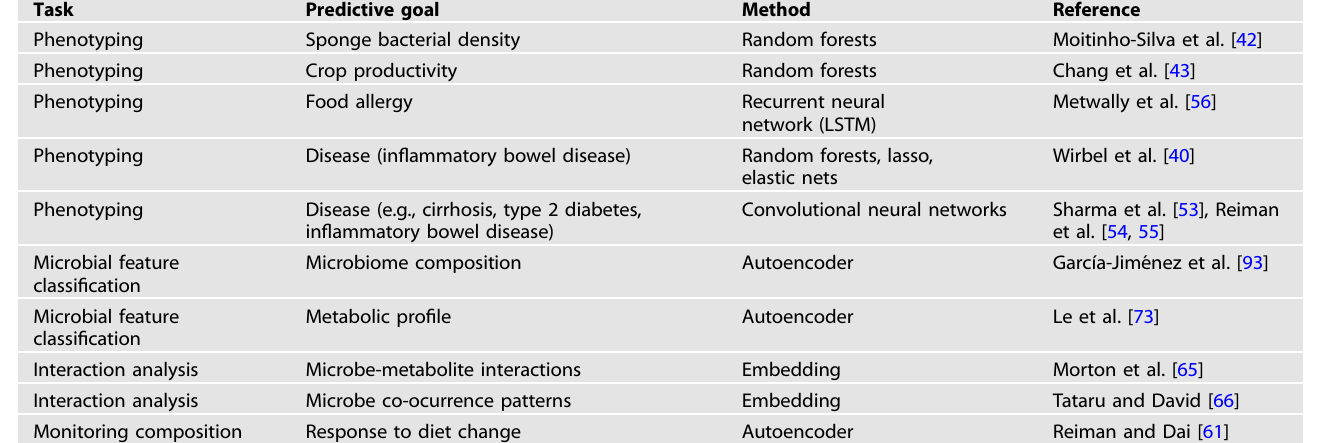
Table 1. Examples of common tasks and ML methods used in microbiome